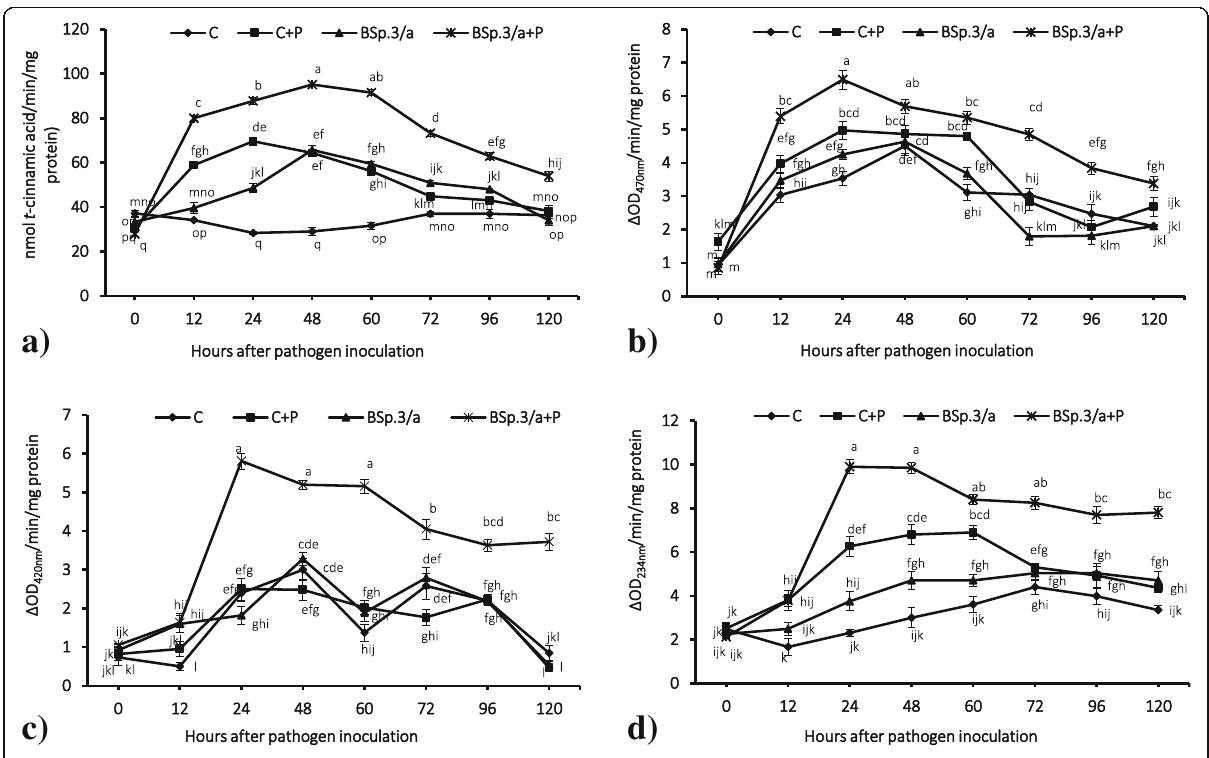
Fig. 3 Influence of PGPR strain BSp.3/aM on defense-related